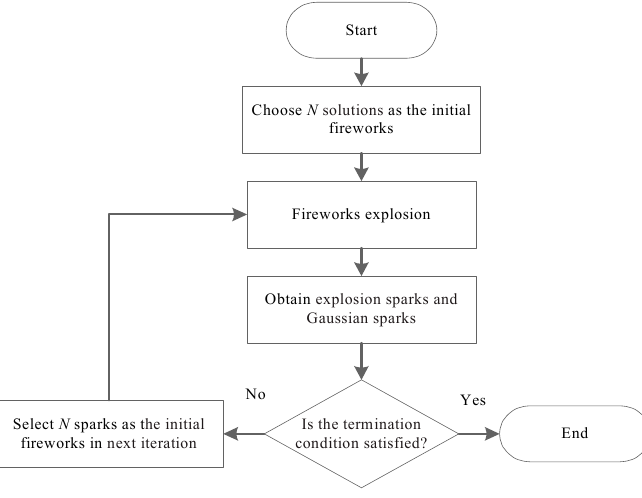
Figure 1. Flowchart of the traditional fireworks algorithm (FWA).